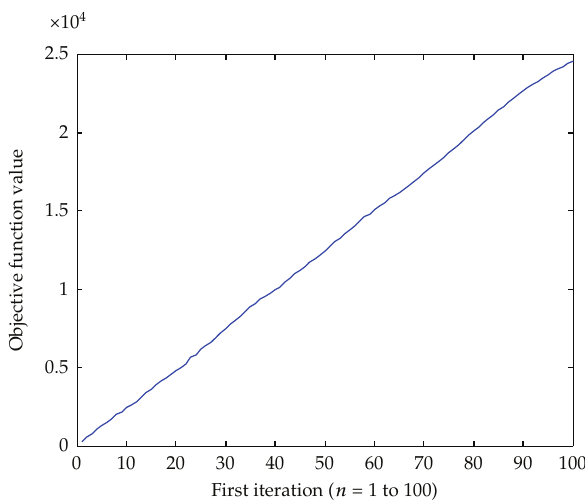
Figure 1: First iteration objective function value for